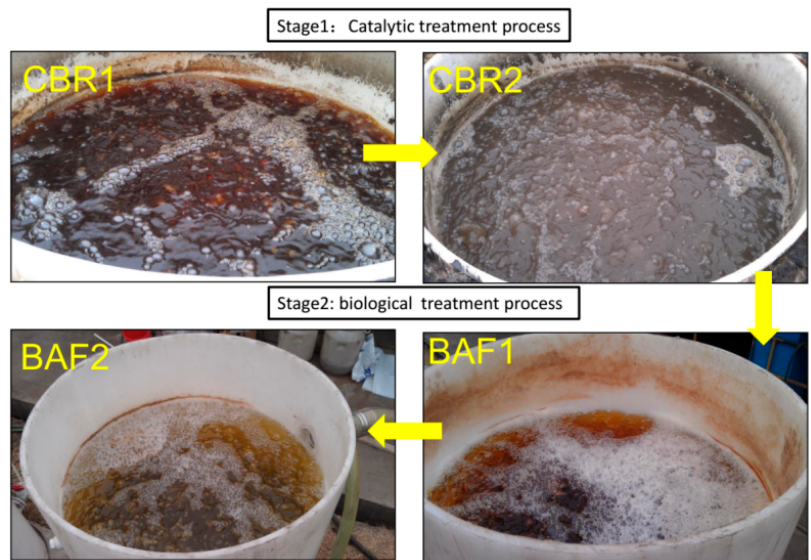
Figure 9. The scene images of the catalytic-biological treatment portion (CBRs and BAFs).